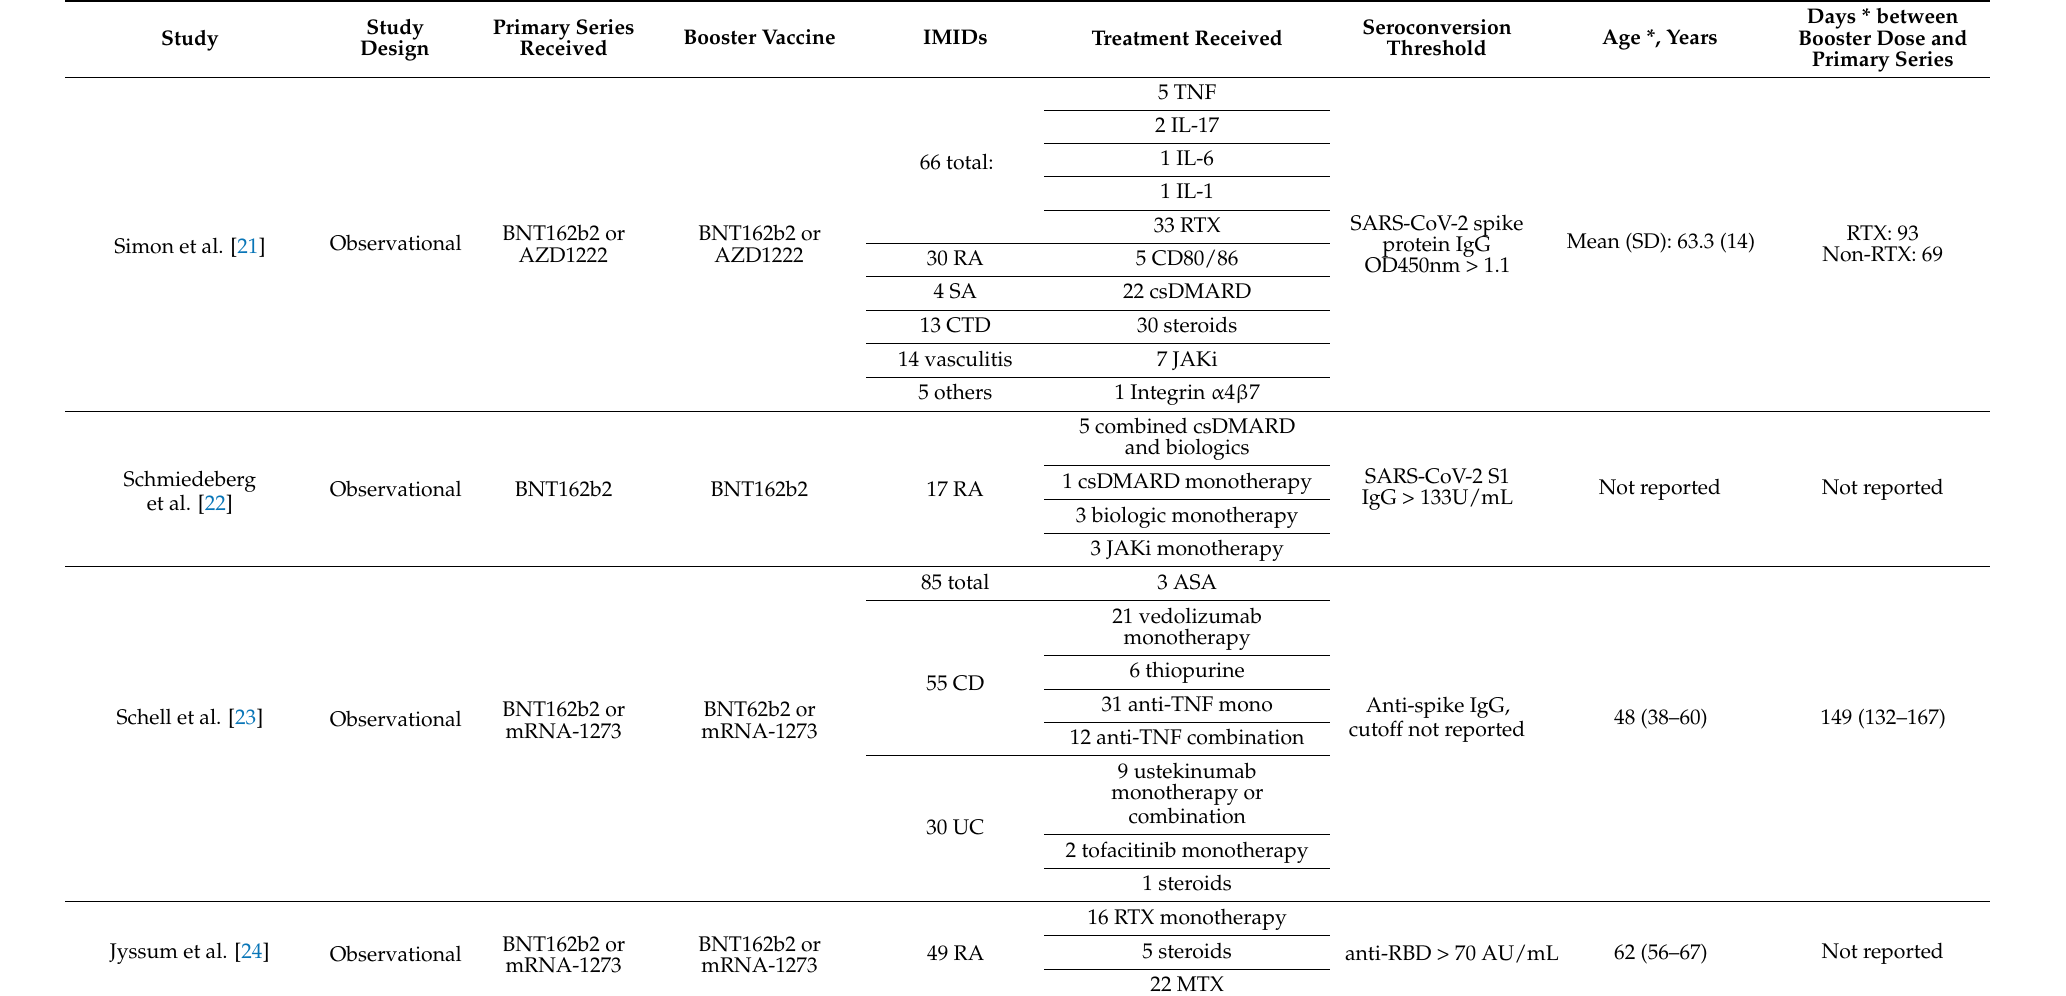
Table 1. Characteristics of included